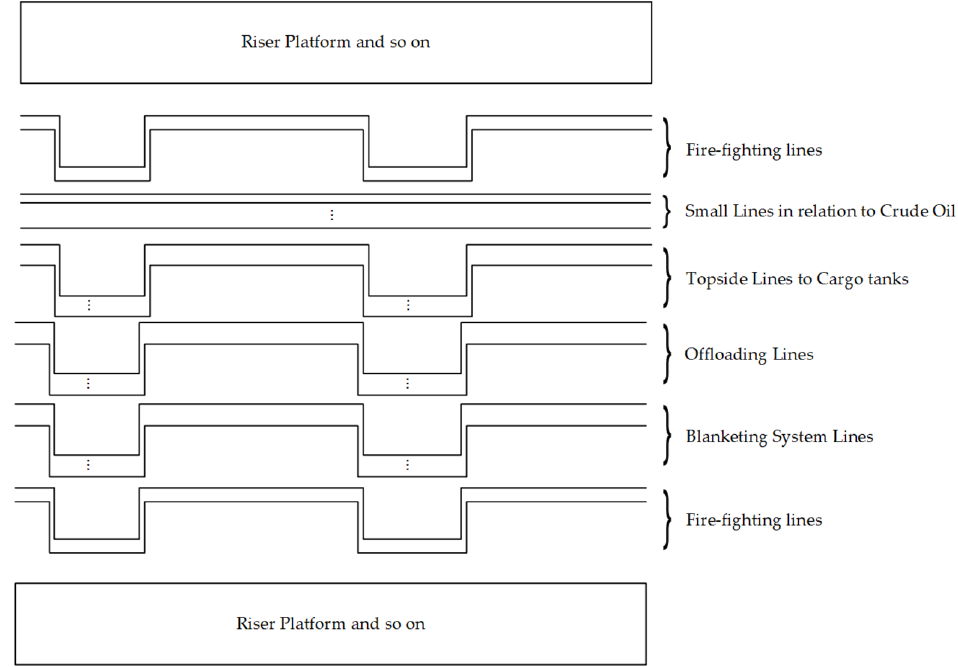
Figure 17. Piping layout considering the width of the ship.